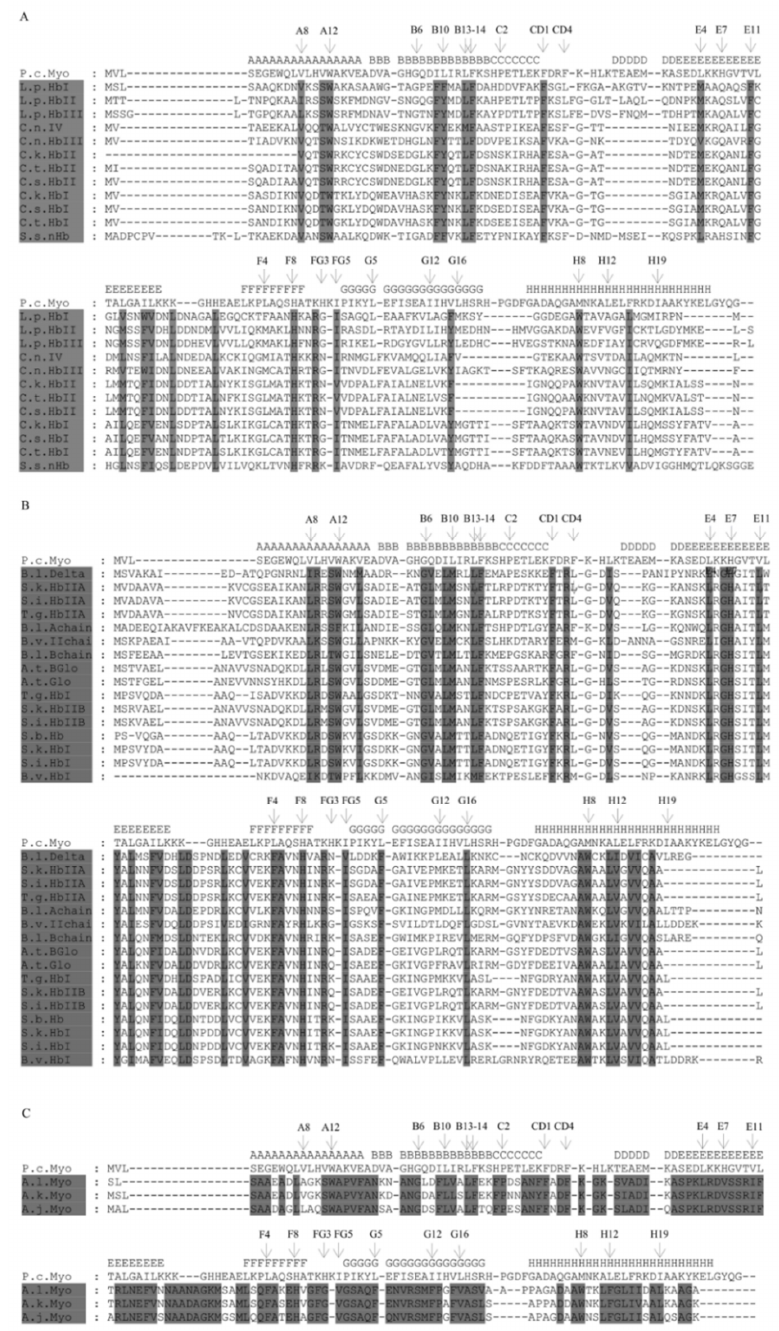
Figure 4. Visualization of Multiple Sequence Alignment showing amino acid residues that are conserved between each clade. ( A ) Bivalves belonging to the Heterodonta subclass. ( B ) Bivalves belonging to Pteriomophia subclass. ( C ) Gastropods belonging to Opisthobranchia subclass. For abbreviations see legend of Figure 2. Above each of the alignments, we indicate the secondary structure of P. catodon Myoglobin according to its crystallographic structure (accession number 1EBC_A). The alignments were visualized using